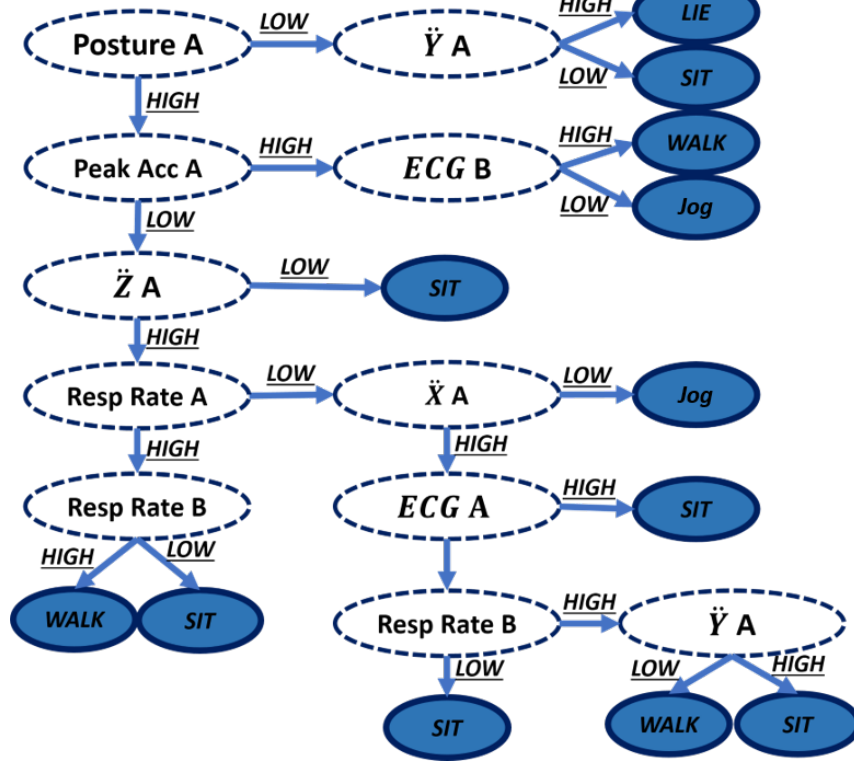
Figure 12. Final decision tree based on the C4.5